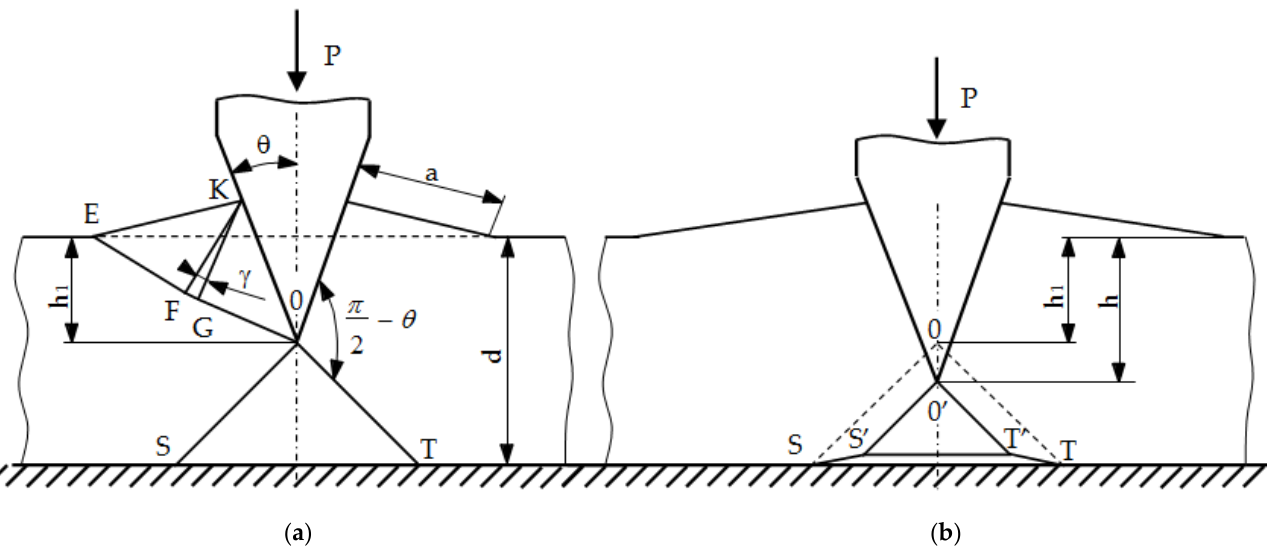
Figure 10. Cutting by wedge-shaped tool: ( a ) phase I; ( b ) phase II.